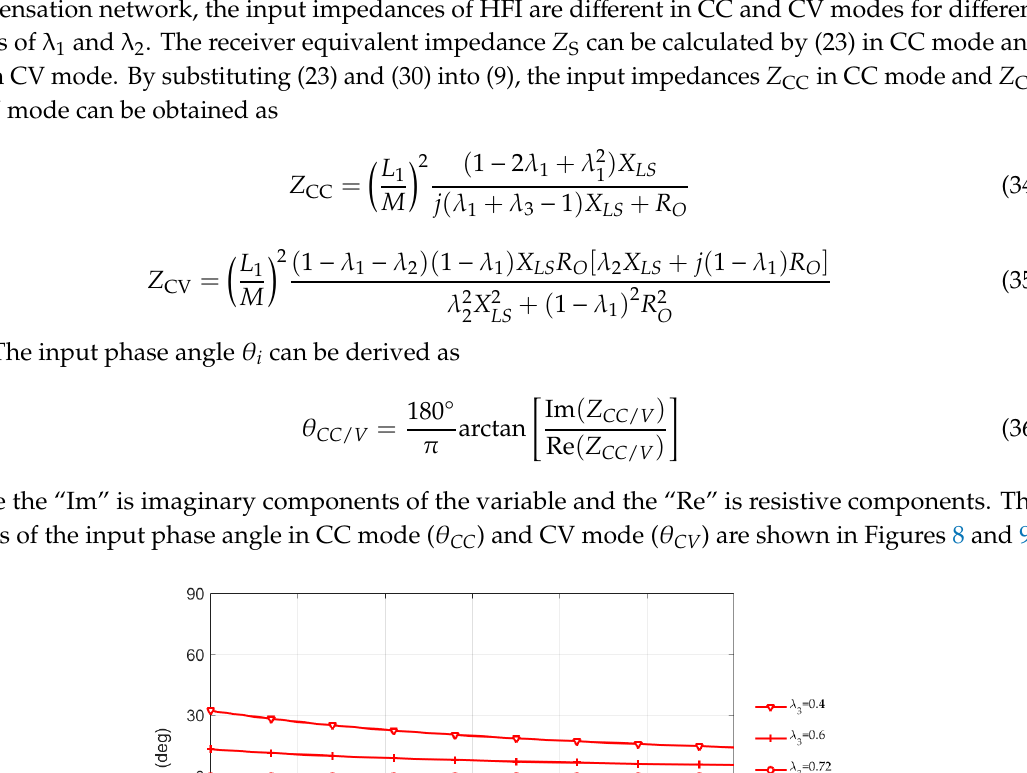
Figure 7. U O versus λ 1 , λ 2 in CV mode.